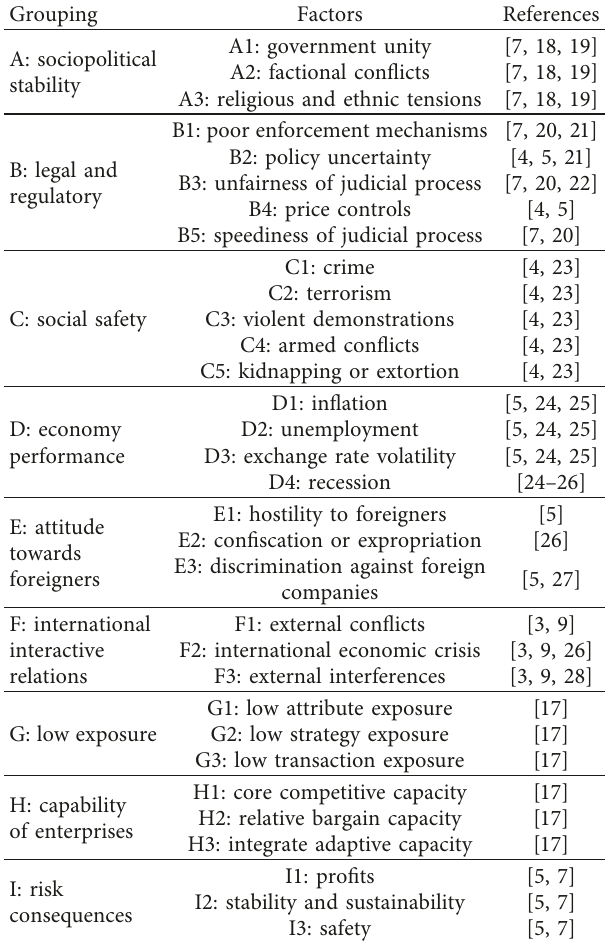
Table 1: Political risk factors and consequences in international construction